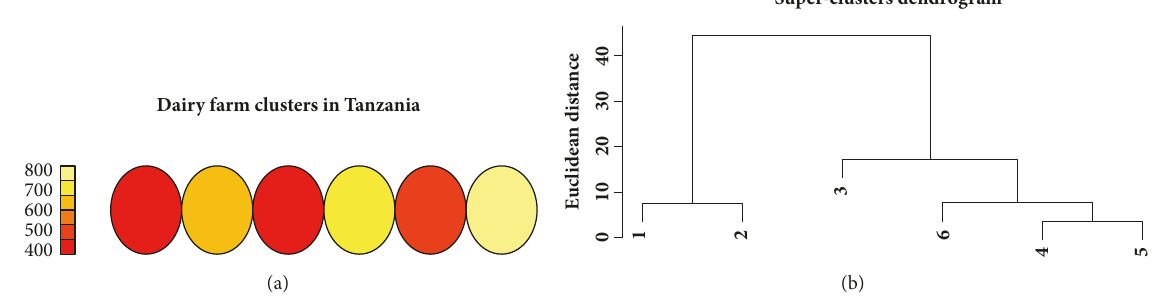
Figure 7: Node counts for household clusters derived using the SOM model for Tanzania (a) and dendrogram for super clusters (b).